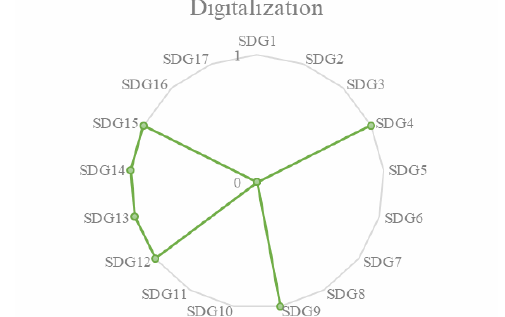
Figure 11. Digitalization cluster of application effect on the SDGs